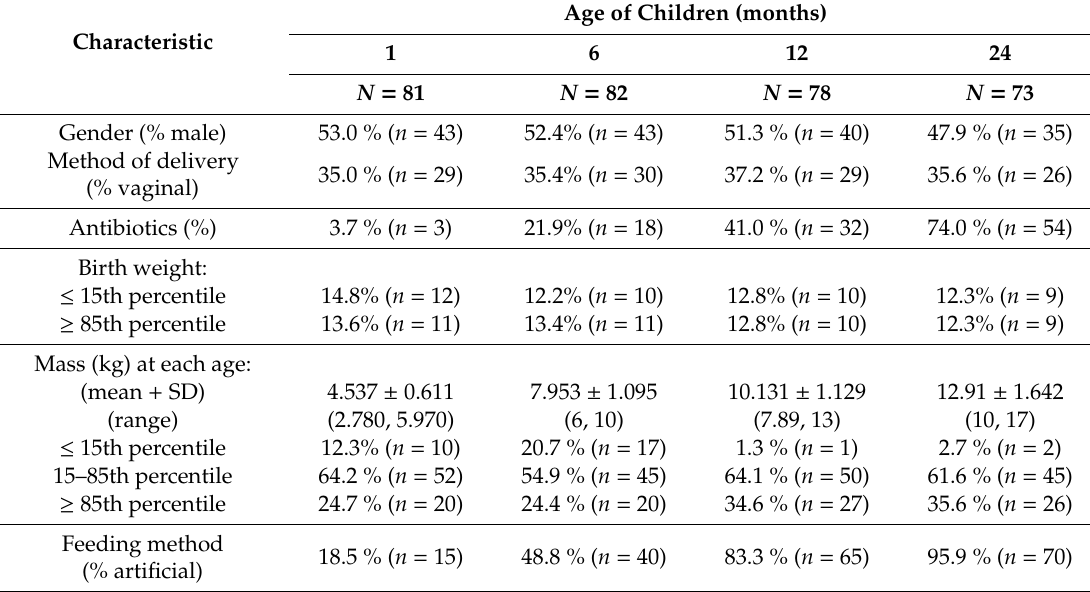
Table 2. Group characteristics: children up to 24 months